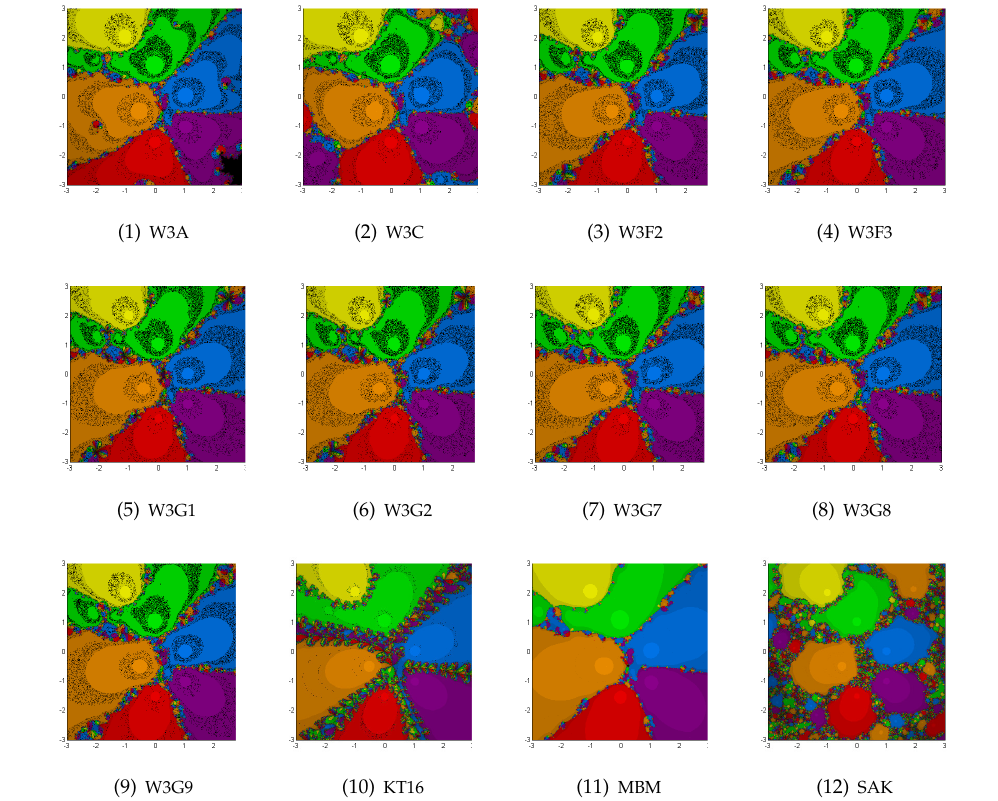
Figure 6. The top row for W3A (left), W3C (center left), W3F2 (center right), and W3F3 (right). The second row for W3G1 (left), W3G2 (center left), W3G7 (center right), and W3G8 (right). The bottom row for W3G9 (left), KT16 (center left), and MBM (center right) and SAK (right), for the roots of the polynomial equation z 6 − 1 11 ( i + 1 )